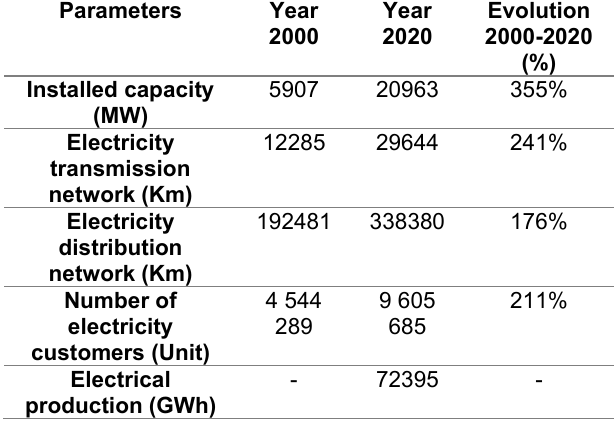
Figure 3. geothermal maps of Algeria [35]